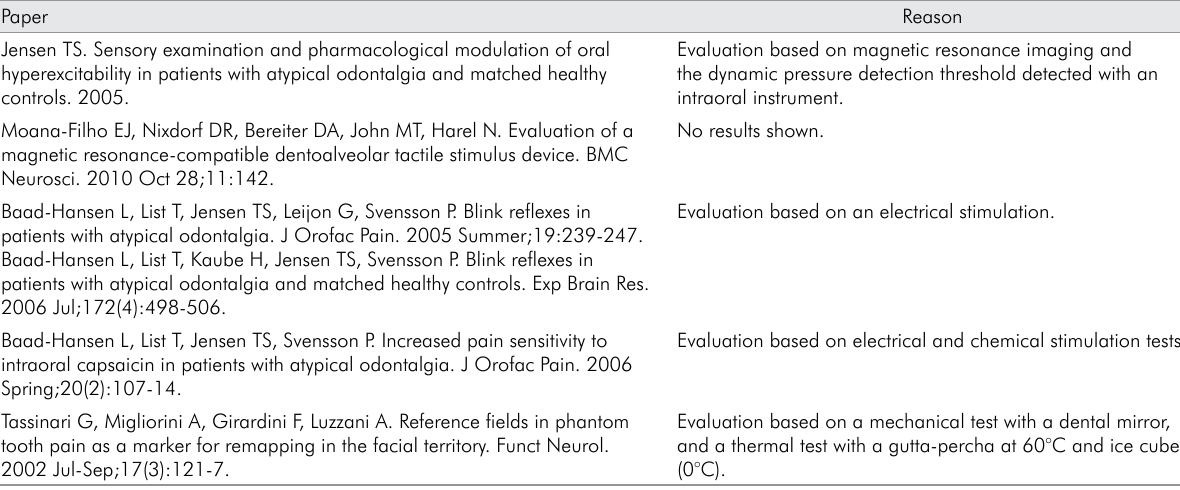
Table 1. Rationale for article exclusion after full-text